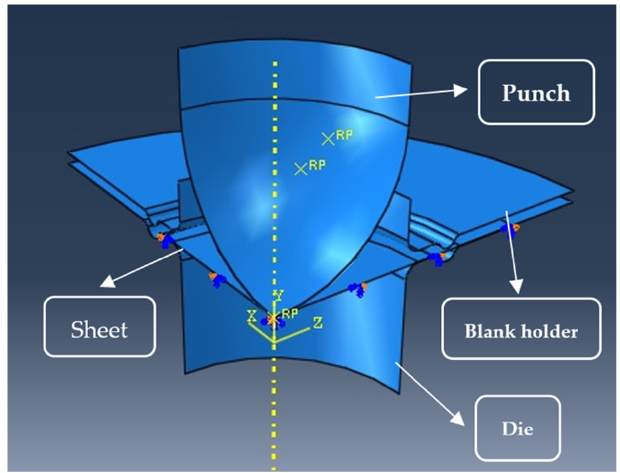
Figure 3. Symmetry boundary condition in the assembled model.